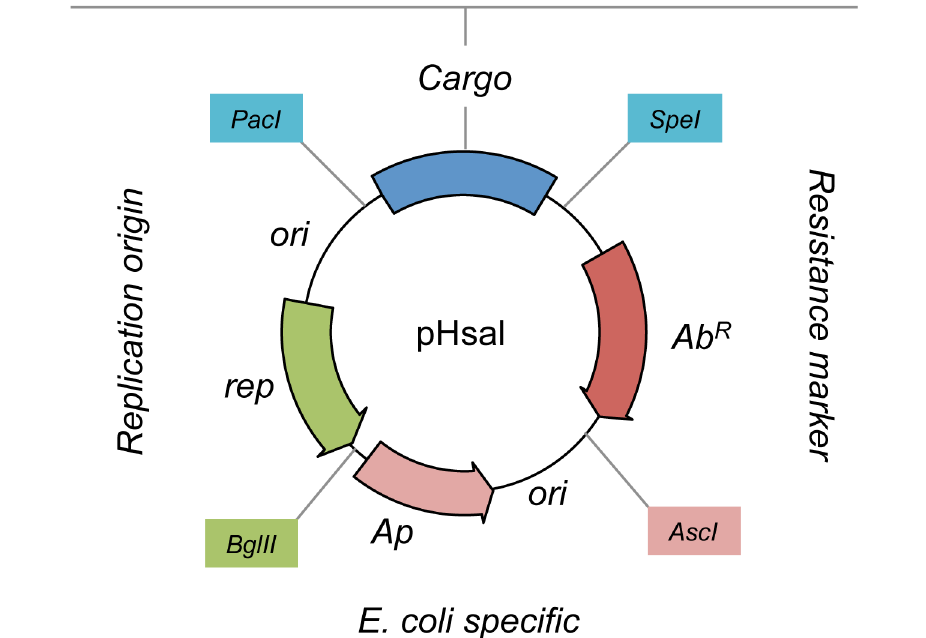
Fig 1. Modular design of pHsal vector series. The format is inspired in the SEVA platform [18] and is divided into four modules: (i) the E . coli specific part (origin of replication and ampicillin resistance gene); (ii) the replication origin; (iii) the resistance marker (tagged as Ab R ) and (iv) the cargo. Each module is flanked by a unique restriction site that allows the easy replacement of a segment by a new sequence (for example, different resistance markers or origin of replications). The cargo is the main region of the vectors since it is used for cloning the fragments of